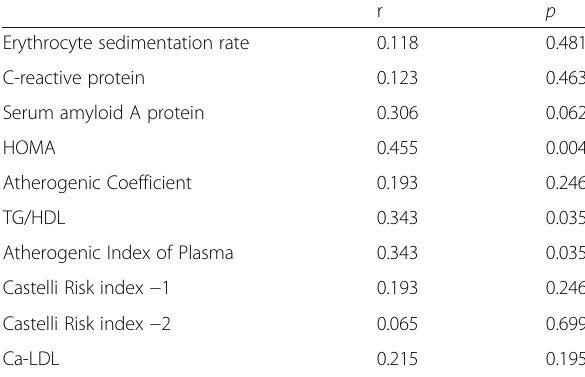
Table 2 Univariate correlation of mean CIMT with selected variables in patients with